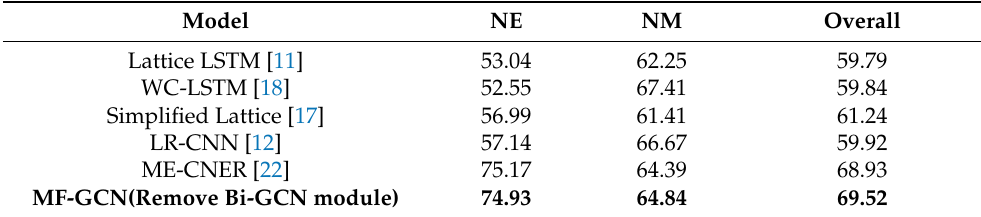
Table 2. Comparison of the recognition effects of different models on the Weibo dataset (unit:%). NE, NM, and Overall represent the F1 scores for named entities, nominal entities (excluding named entities), and